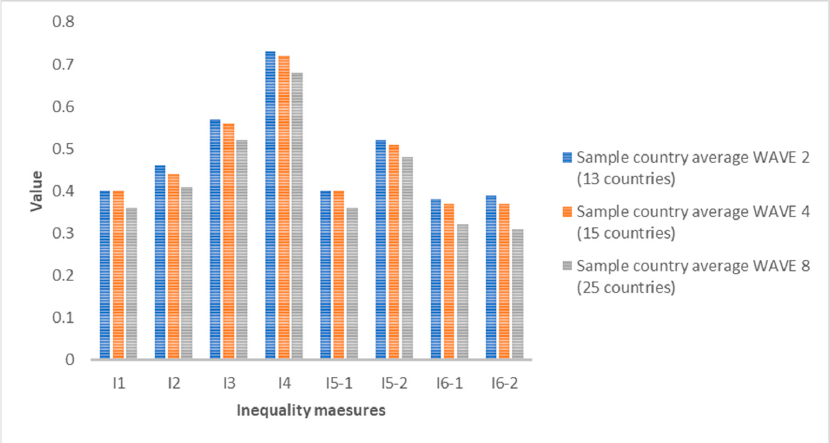
Figure 2. Average values for each inequality indicator for women in Wave 2 (2006), Wave 4 (2010) and Wave 8 (2020). Source: Authors’ elaboration based on SHARE (2021).